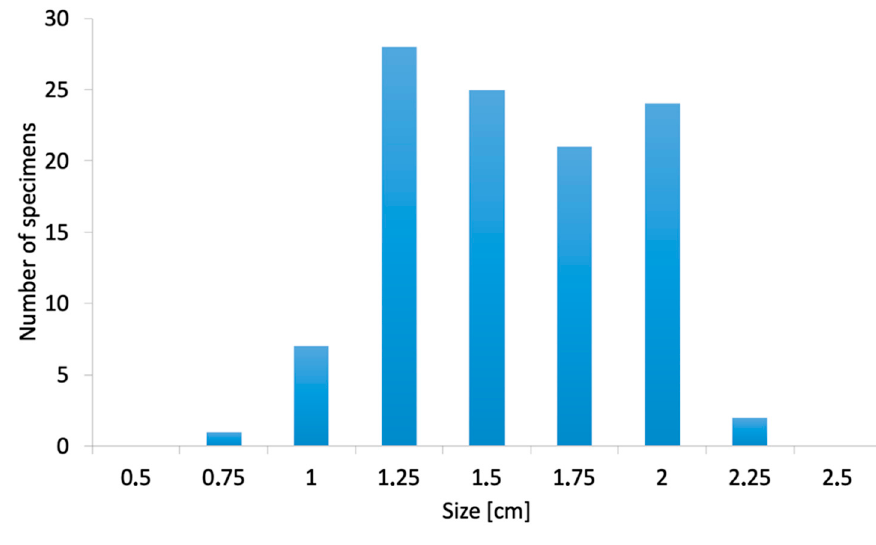
Figure 4. Distribution (number) of heights of artificial colonization.